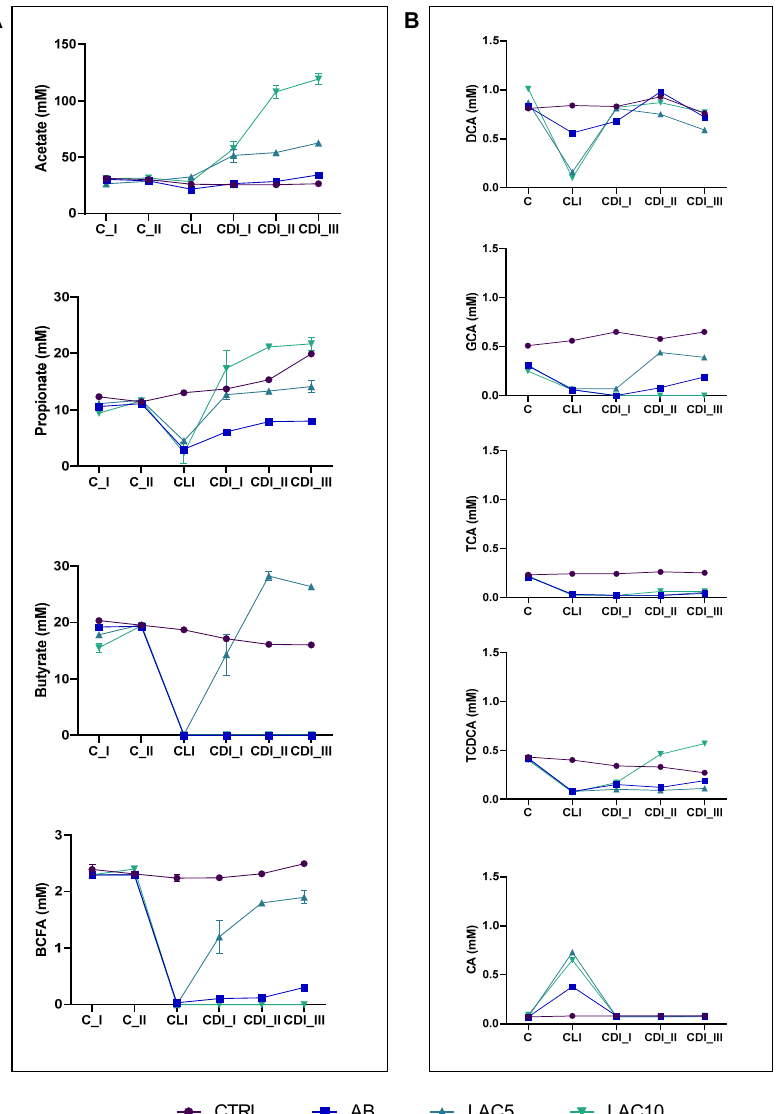
Figure 3. ( A ) Acetate, propionate, butyrate and branched-chain fatty acid (BCFA) levels (mM) in the proximal colon reactors and ( B ) taurocholic acid (TCA), taurochenodeoxycholic acid (TCDCA), glycocholic acid (GCA), deoxycholic acid (DCA) and cholic acid (CA) in the distal colon reactors during the course of the control period (C_I-II), the clindamycin treatment period (CLI) and the CDI stabilization period (CDI_I-III) of the PathoGut™ SHIME experiment for four of the experimental arms, including arm 1 (CTRL), arm 2 (AB), arm 3 (LAC5) and arm 4 (LAC10). Dots represent mean ± SEM ( n = 3) for acetate, propionate, butyrate and BCFA, whereas n = 1 for TCA, TCDCA, GCA, DCA and CA. Two-way ANOVA was used to calculate statistically significant differences between the experimental test arms, with significance highlighted in the text ( p <